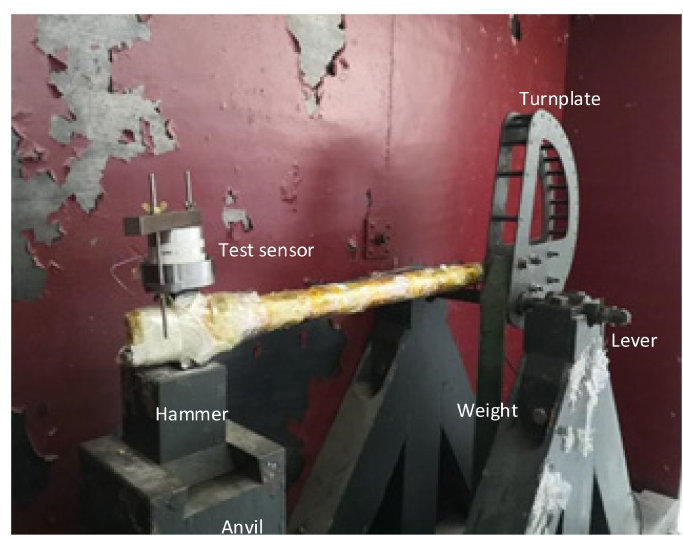
Figure 6. Machete